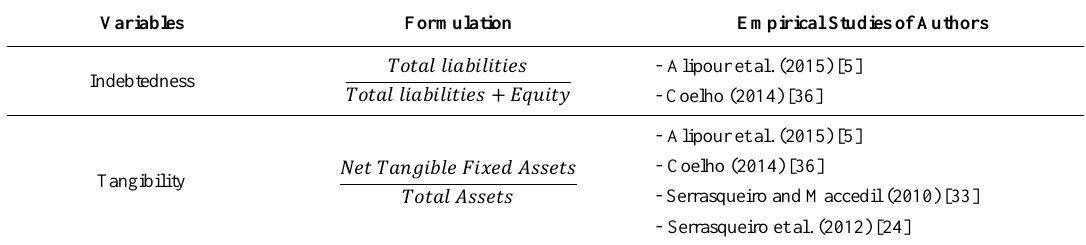
Table 1. Dependent variable and independent variables in the